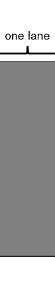
Figure 16. Desired left-, middle-, and right-edge clustering of extracted lane segments based on road delineation.